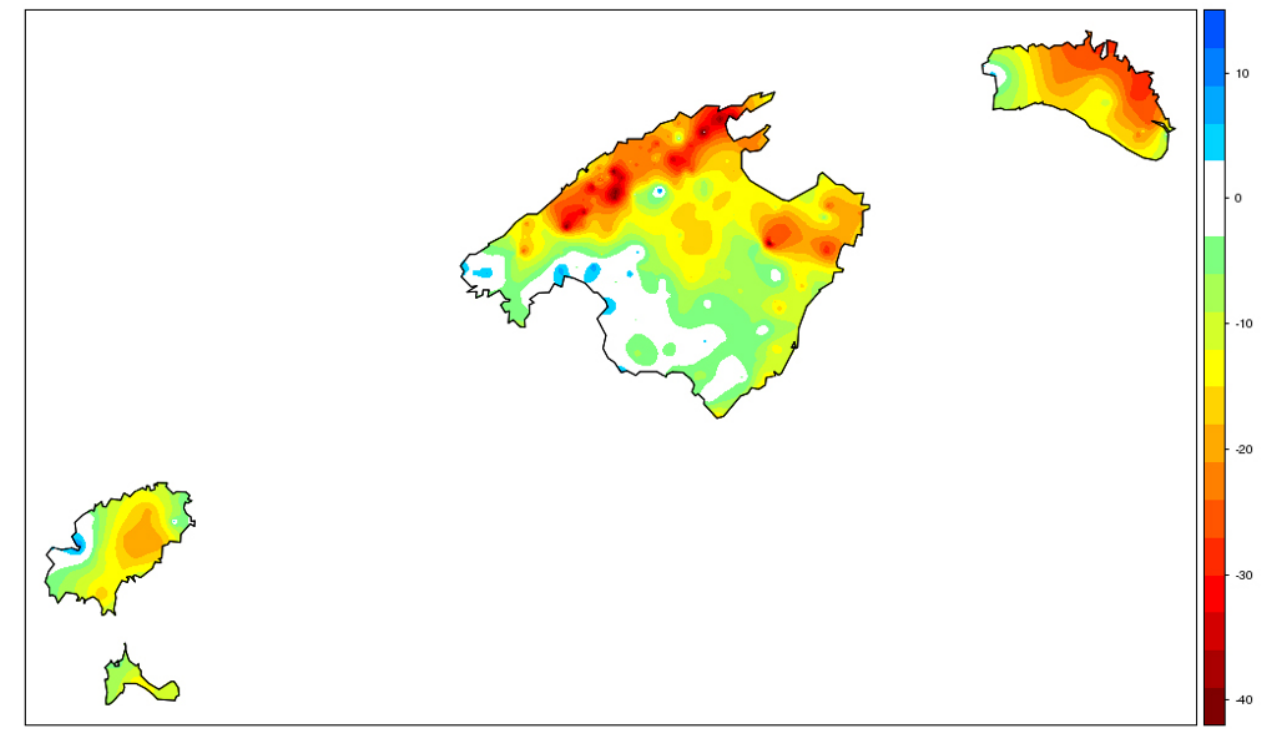
Figure 8. Annual precipitation trend (mmdecade − 1 ) across the Balearic Islands for 1950–2009.